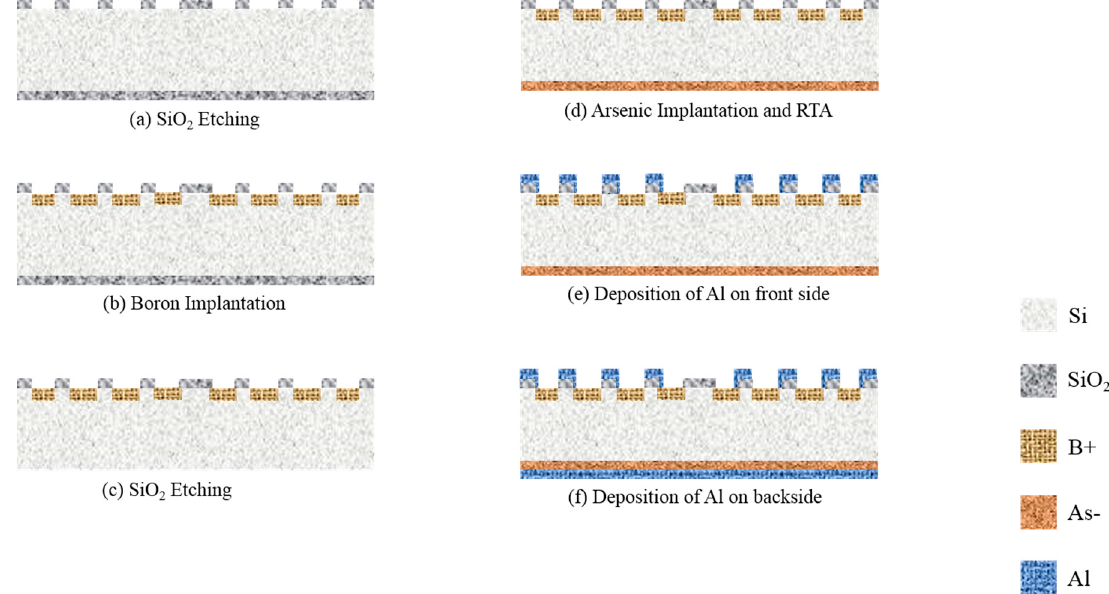
Figure 2. The schematic fabrication processes of the MA BSE detector. ( a ) Front side working areas. A 500 nm-silicon dioxide layer is etched. ( b ) Ion implantation of boron ions on front side. ( c ) A 500 nm-silicon dioxide on backside is etched. ( d ) Backside ion implantation by arsenic ions and then RTA treatment at 950 °C for 60 s. ( e ) A 600 nm-aluminum film is deposited on front side. ( f ) A 600 nm-aluminum layer is deposited on backside.